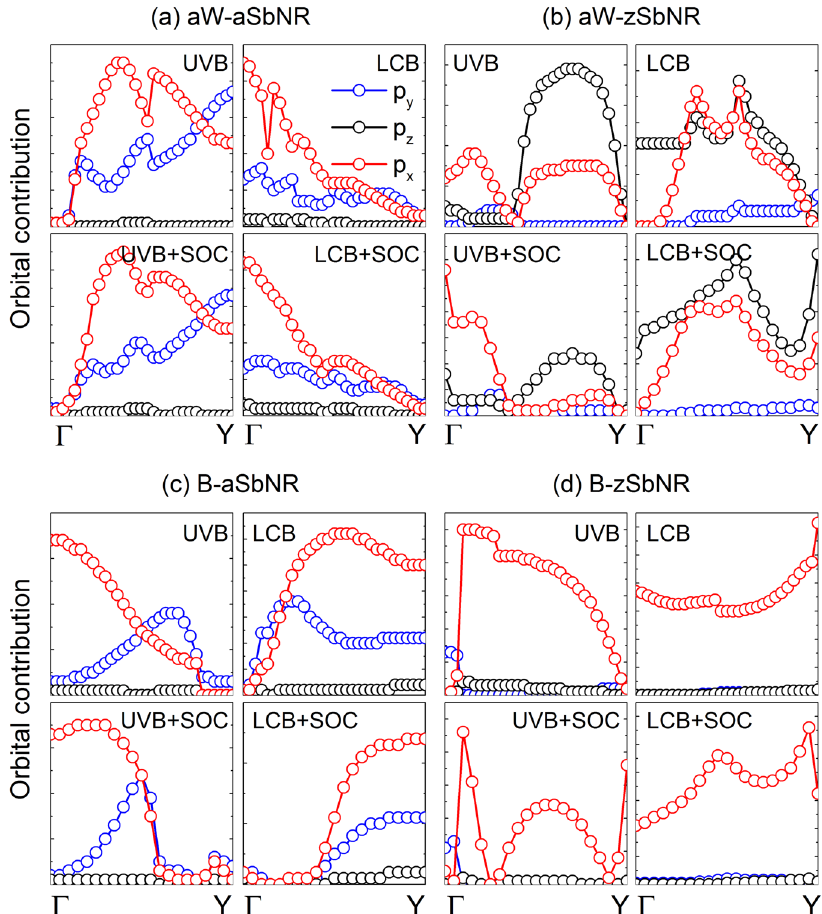
Fig. 4 Orbitally resolved contributions of the edge atoms to the UVB and LCB in arbitrary units for a aW-aSbNR, b aW-zSbNR, c B-aSbNR, and d B-zSbNR,